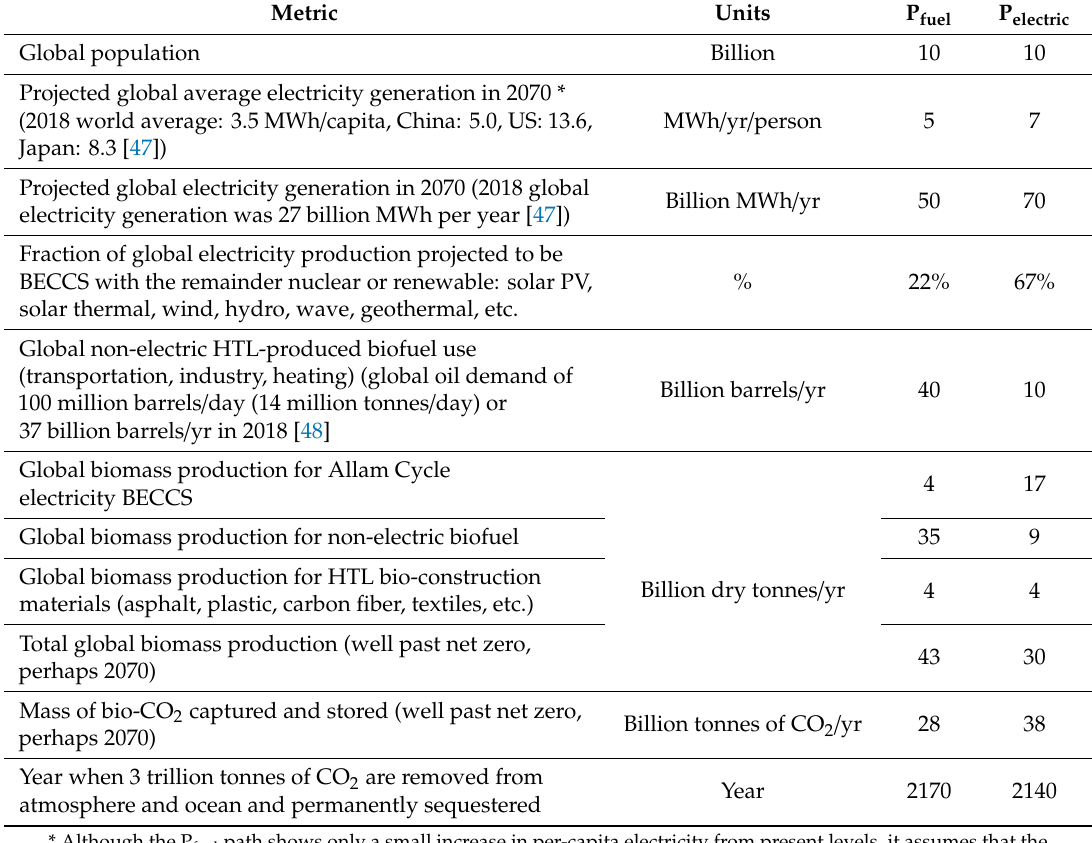
Table 2. Two paths of energy demand and supply a few years (~2070) after net CO 2 emissions drop to zero around 2050 (SMS#2). Metric Units P fuel P electric Global population Billion 10